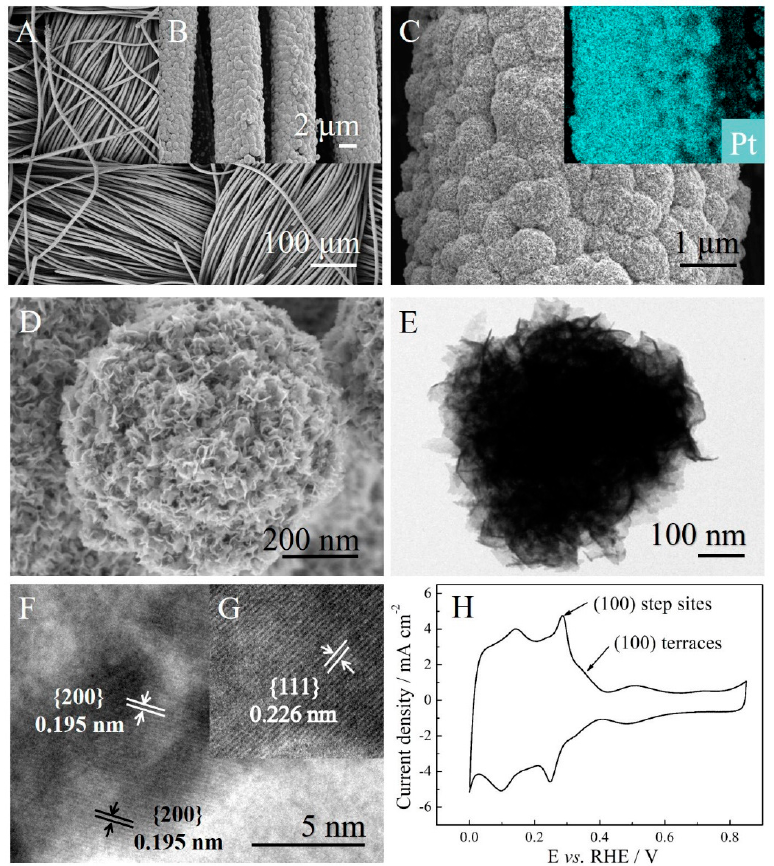
Figure 1 . SEM images of Pt NFs / CC ( A , B , C , D ) at different magnifications. Inset of ( C ) is the corresponding elemental mapping image; TEM image ( E ), HRTEM images ( F , G ) of the Pt NF; cyclic voltammogram ( H ) for the Pt NFs / CC in 0.5 M H 2 SO 4 at 20 mV s − 1 .